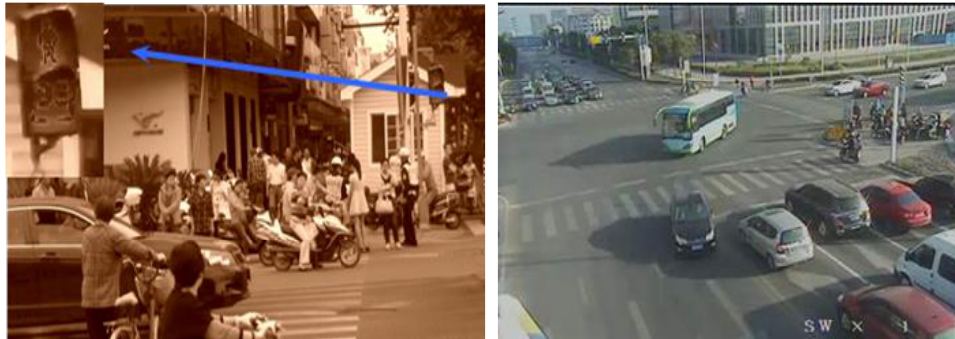
Figure 3. The process of data acquisition from surveillance videos of intersections. Table 1. Variable assignment of risk factors.